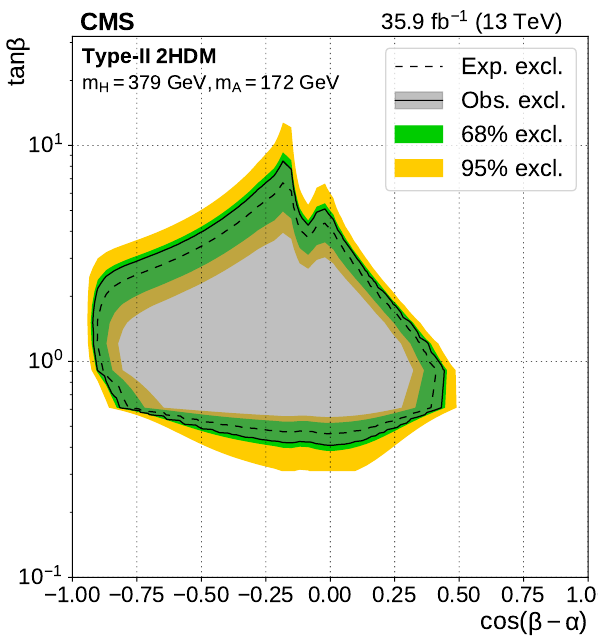
Figure 9 . Expected and observed 95% CL exclusion contours for m m = 172 GeV as a function of tan (cid:12) and cos( (cid:12) (cid:0) (cid:11) ). The inner (green) band and the outer (yel- A low) band indicate the regions containing 68 and 95%, respectively, of the distribution of the exclusion contours expected under the background-only hypothesis. The limits are computed using the asymptotic CL method, combining the ee and (cid:22)(cid:22) s